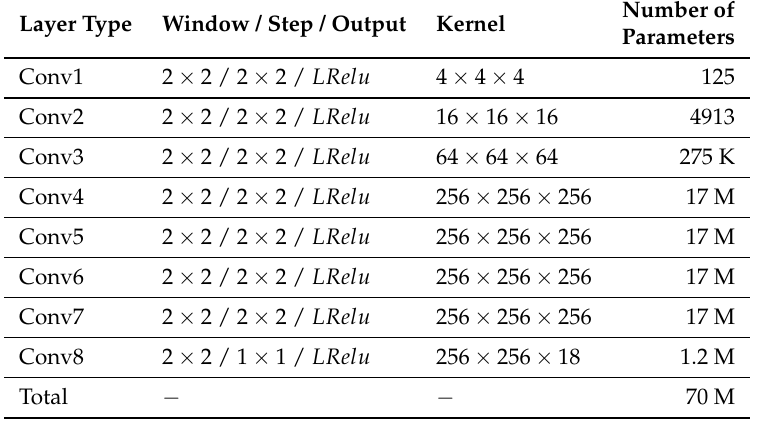
Table 2. Composition of the neural network for regression of a grid of reference